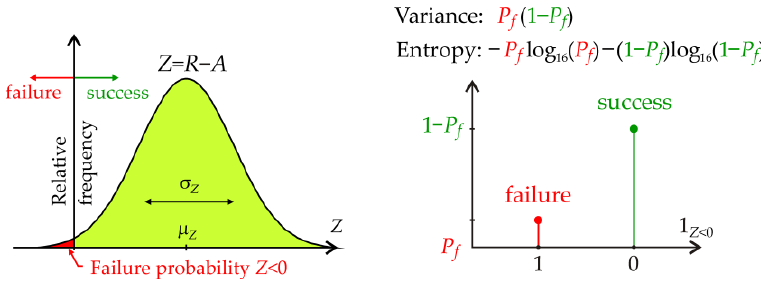
Figure 3. The failure probability P f in the Bernoulli trial.